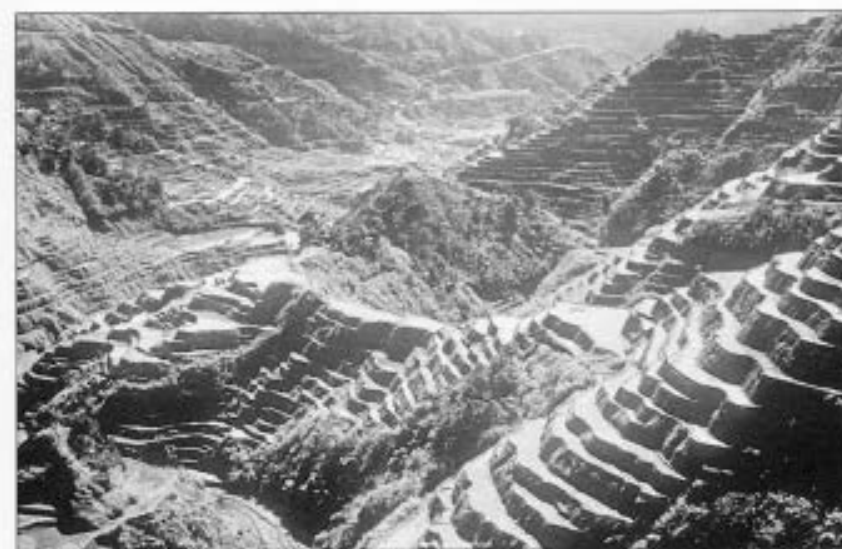
Figure 1 Wet-padi (rice) terraces of the I fuga a at Baraue, Luzon, Philippines. ensembles of various kinds, 18 per cent are historic towns, and 12 per cent archaeo­ logical sites, whereas only 7 per cent are cultural landscapes, 5 per cent are indus­ trial properties, and 1 per cent are heritage of the late nineteenth and twentieth cen­ turies.